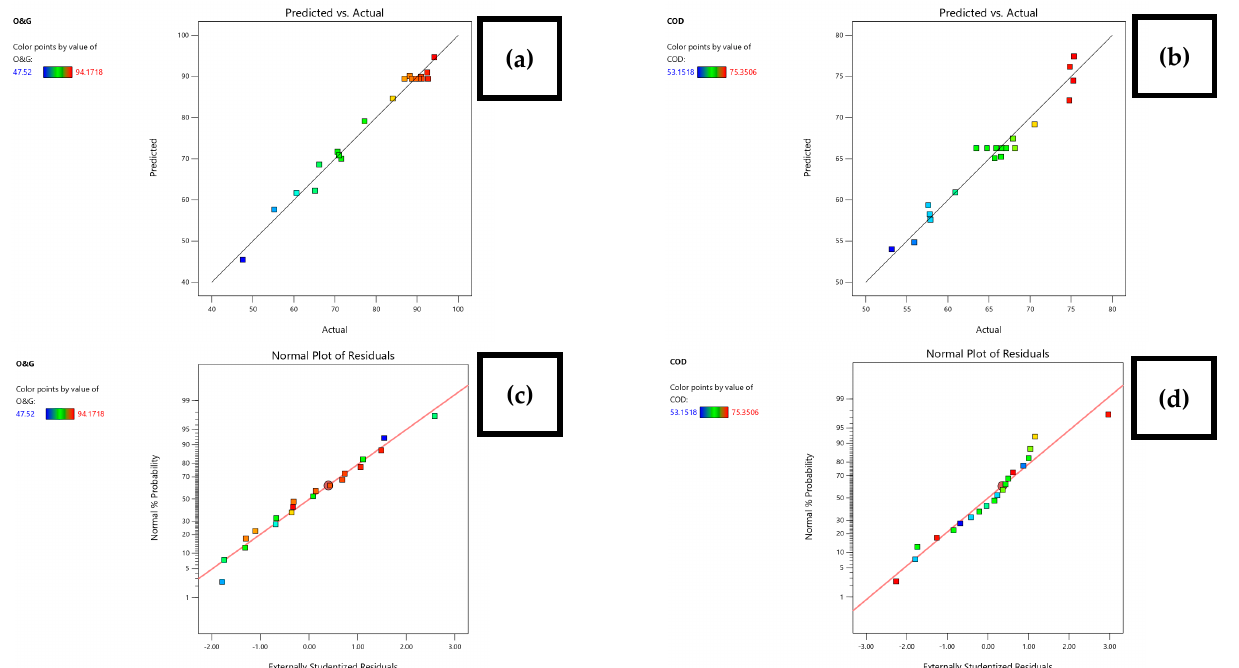
Figure 7. The actual value versus the predicted value: ( a ) O&G, ( b ) COD, normal distribution plots ( c ) O&G, and ( d ) COD.